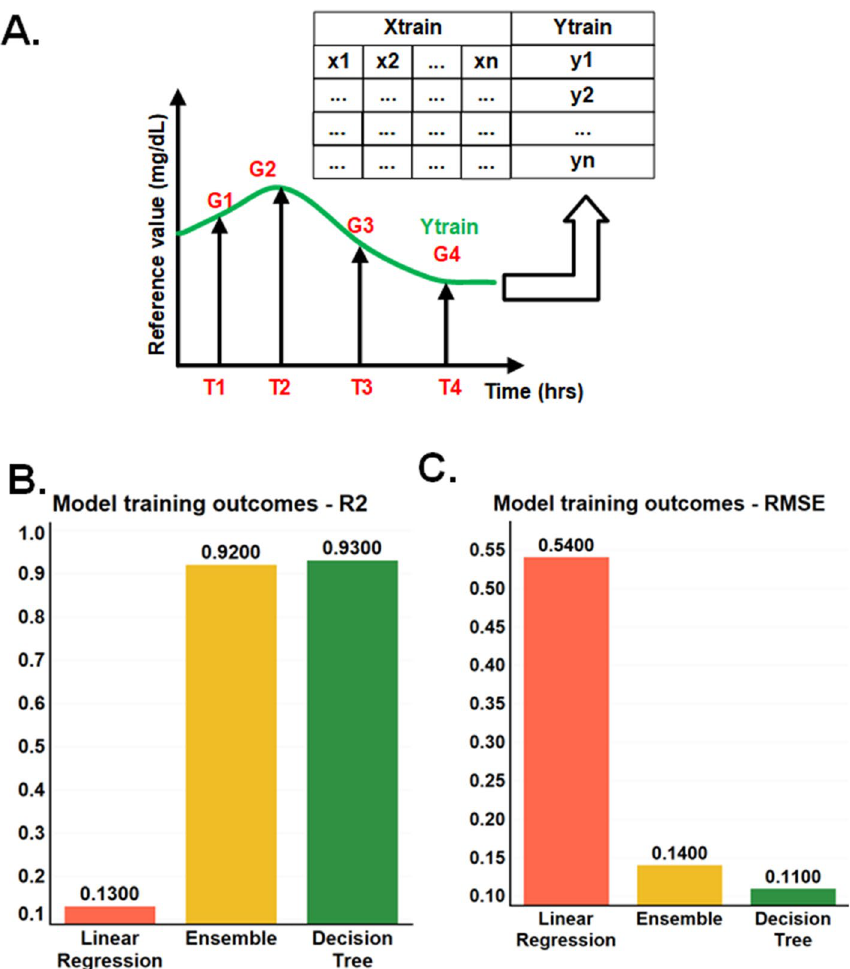
Figure 3. ( A ) Concept diagram of interpolation signal generation using reference points, ( B ) bar plot comparison of R 2 value obtained from k-fold cross-validation for regression algorithms, ( C ) bar plot comparison for RMSE value obtained from k-fold cross-validation for regression